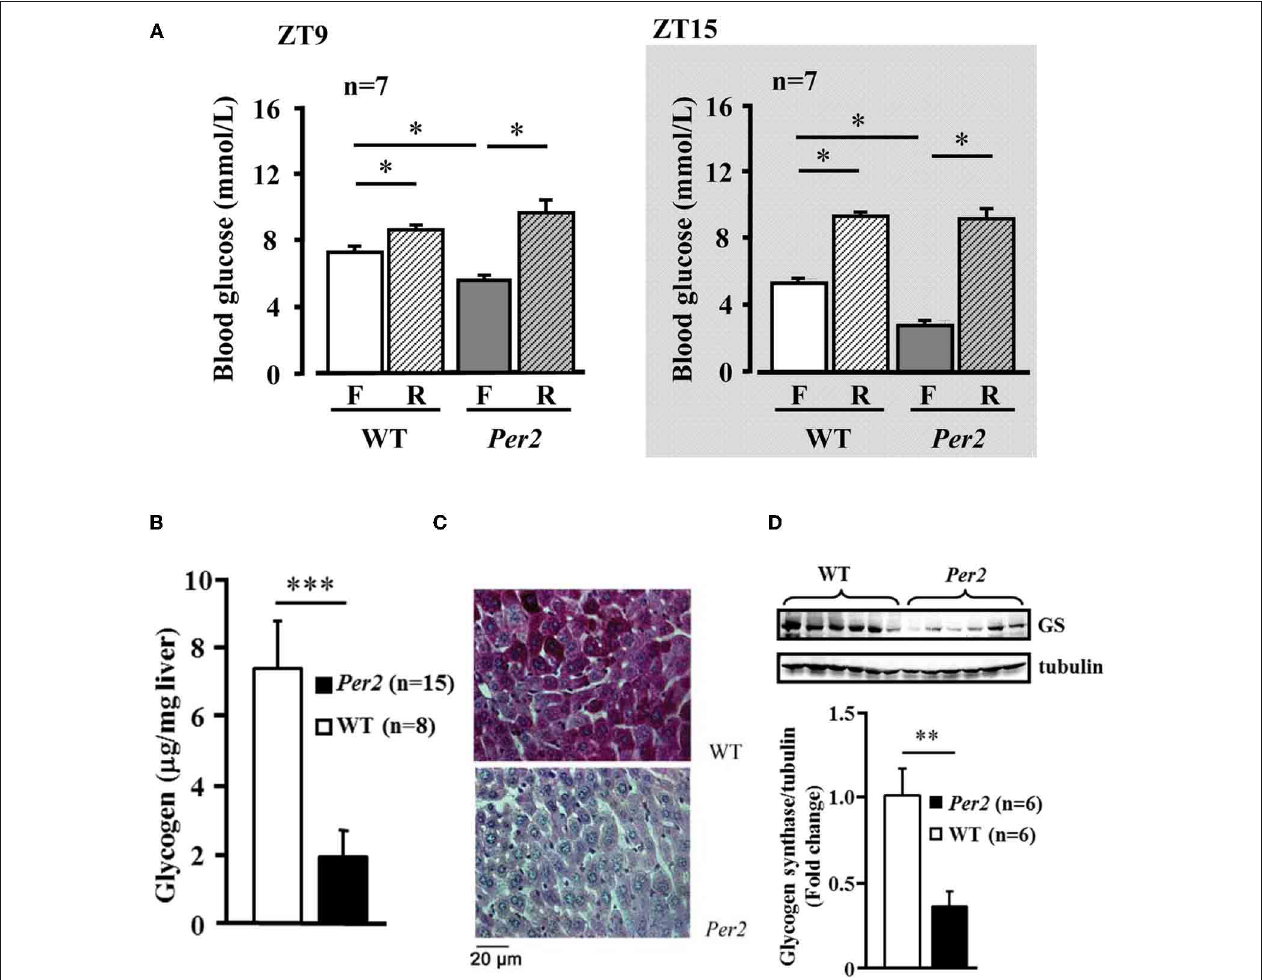
FIGURE 4 | Decreased fasting plasma glucose concentration and hepatic glycogen content in mPer2 Brdm1 mice. (A) Decreased fasting (F) blood plasma glucose concentration in the mPer2 Brdm1 mice as compared to WT littermates at ZT9 and ZT15, which is normalized after refeeding (R). (B) Fasting hepatic glycogen content of WT and mPer2 Brdm1 mice at ZT9.